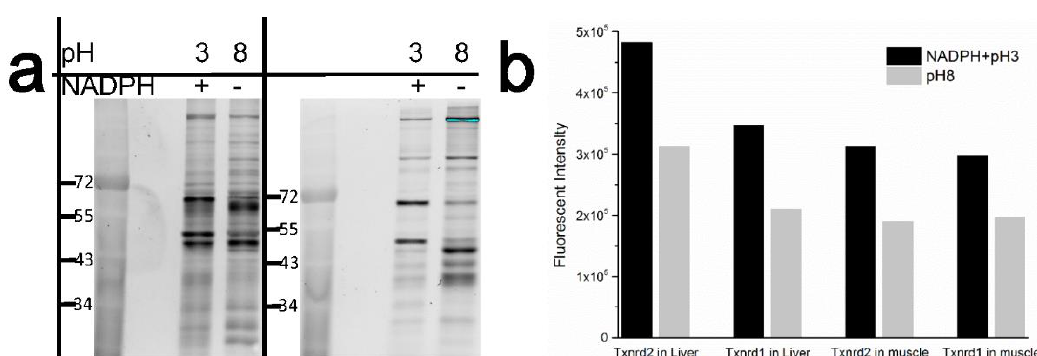
Figure 6. ( a ) SDS-PAGE fluorescence image of Nap-I-labeled TXNRD from Tan sheep liver and muscle reduced by NADPH at pH 6.5 with labeling at pH 3 and 8; ( b ) comparison of Nap-I-labeled TXNRDs from Tan sheep liver and muscle, with or without reduction and labeling at low pH. Quantity of protein per band: ca. 1 μg.